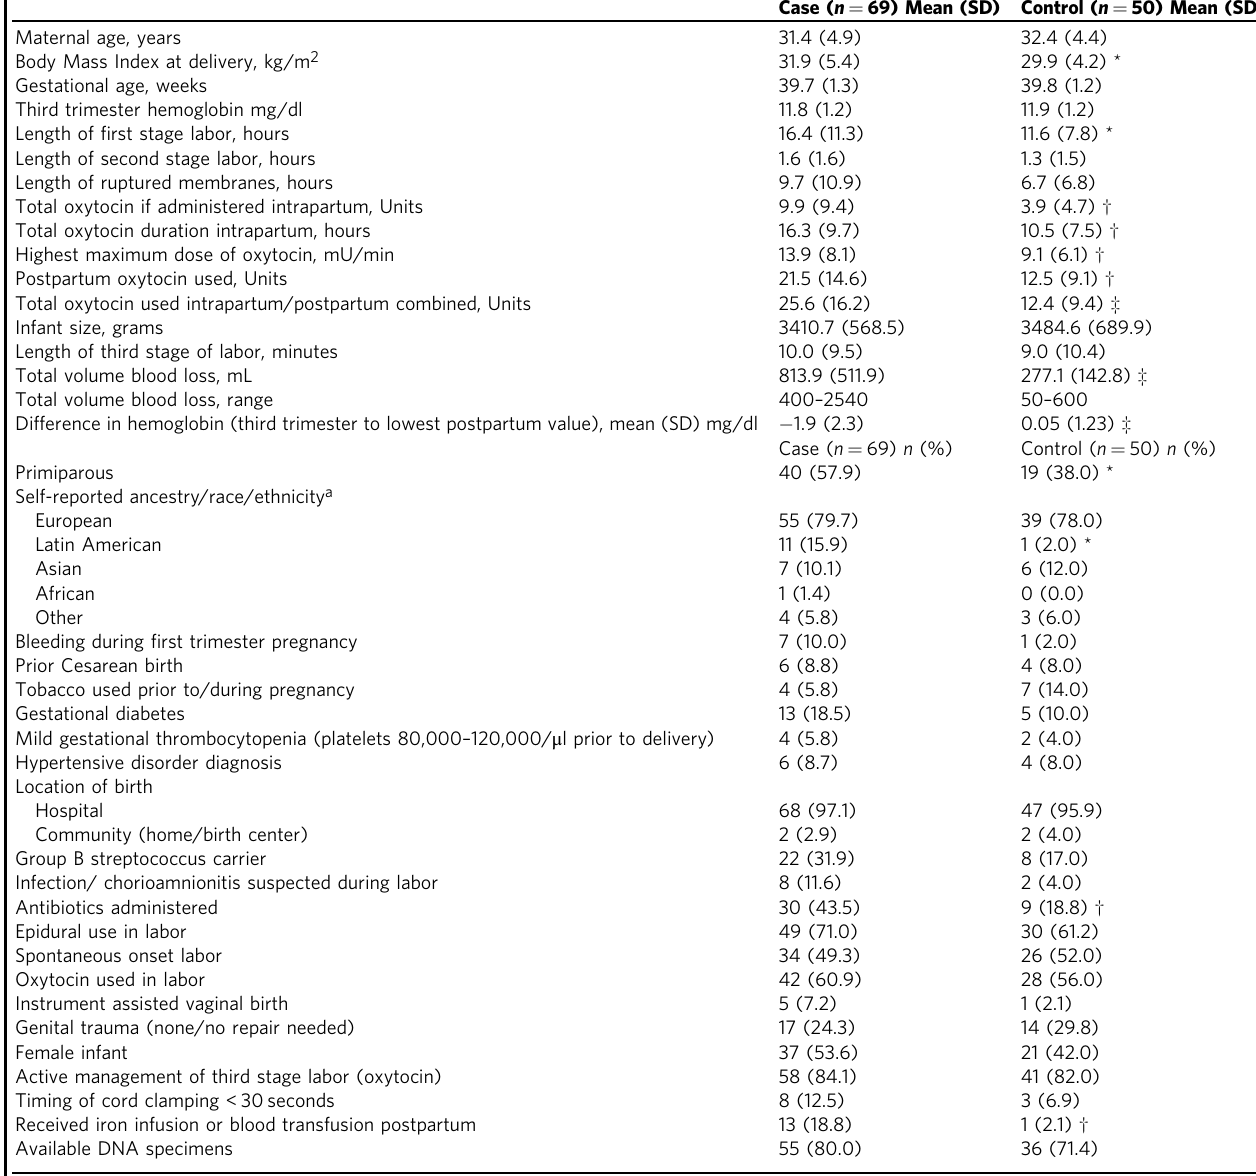
Table 1 Signi fi cant differences in total oxytocin administration during labor between postpartum hemorrhage cases compared to controls, matched on parity and labor induction and other sample